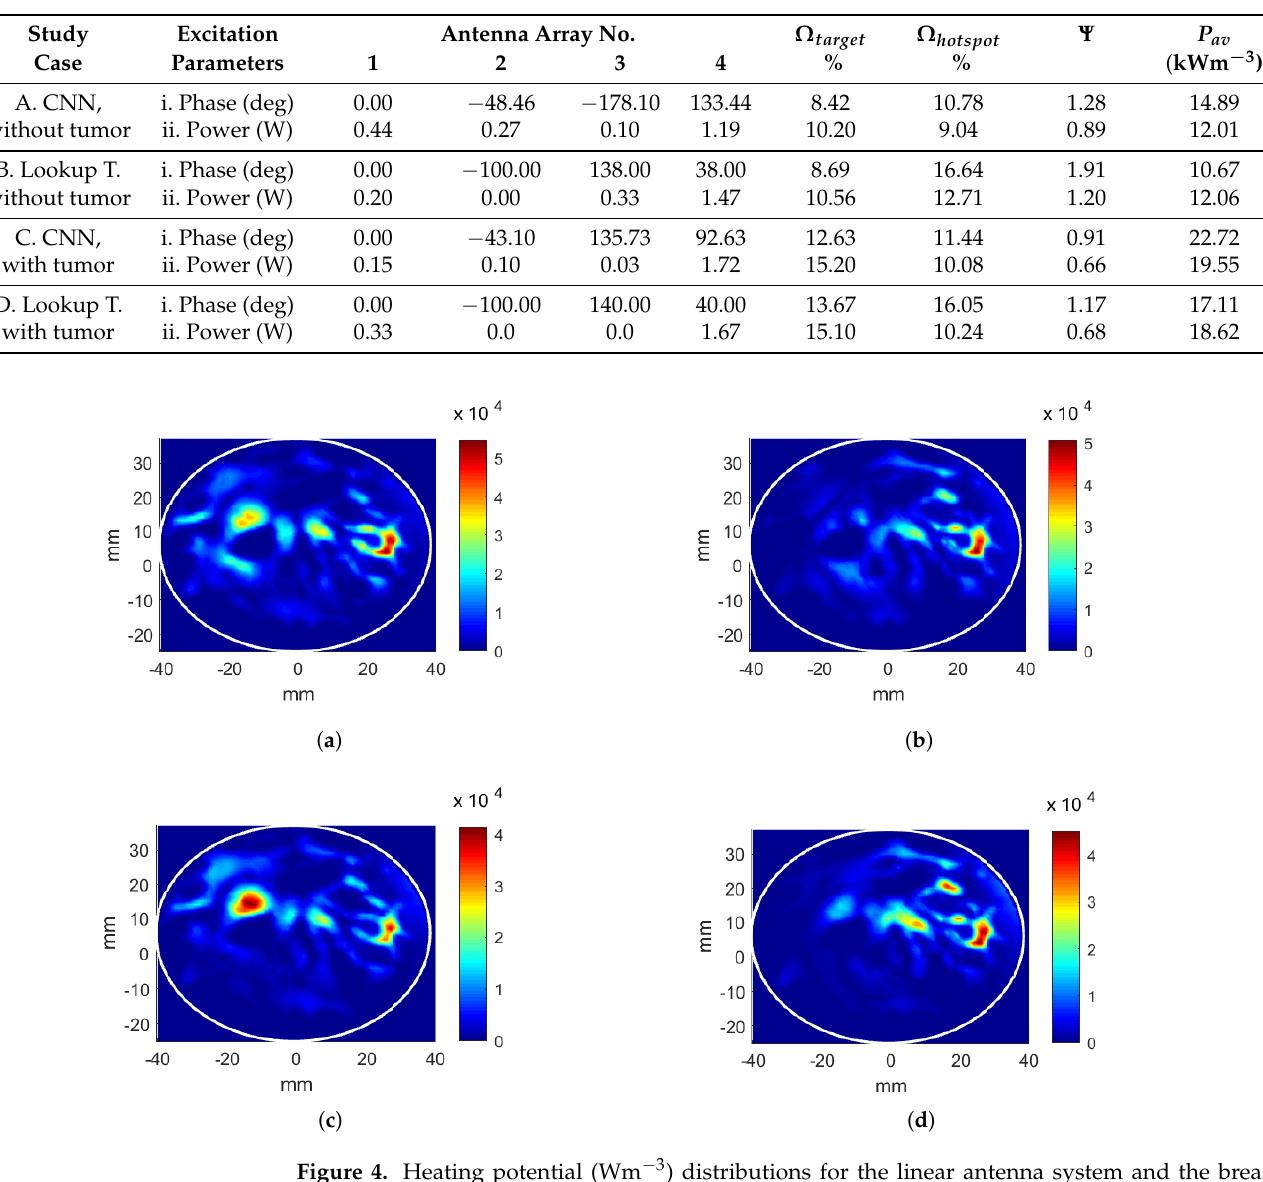
Table 1. Estimated linear antenna excitation parameters for target at (26, 12, 0) mm.